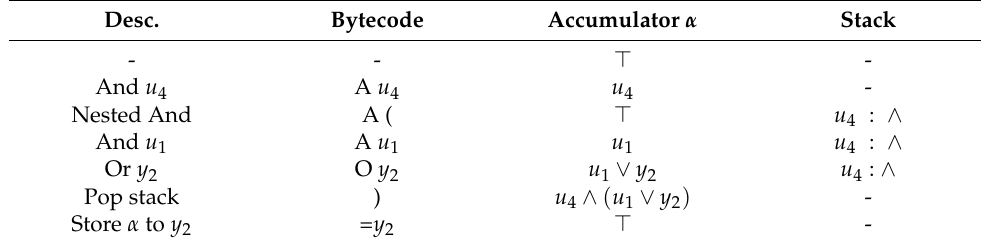
Table 1. Example accumulation of a constraint.